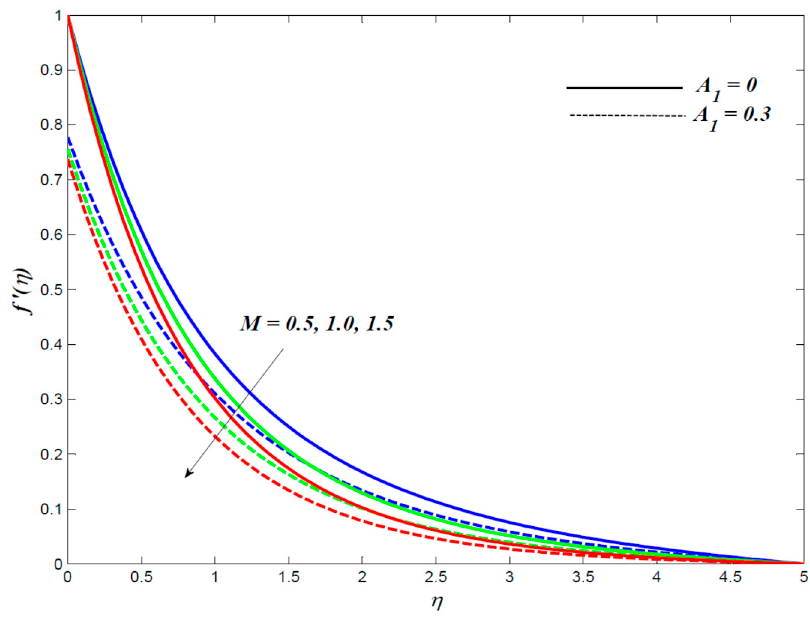
Mathematics 2020 , 8 , x FOR PEER REVIEW Figure 2. Velocity profiles owing to varying values of M . Figure 2. Velocity profiles owing to varying values of M .